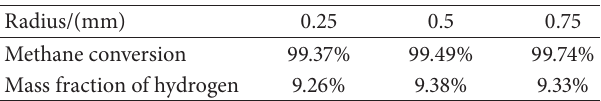
Table 4: Mass fraction of hydrogen and methane conversion with different cylinder radius.